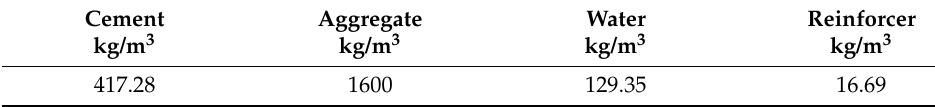
Table 2. Amount of each material per cubic meter of permeable